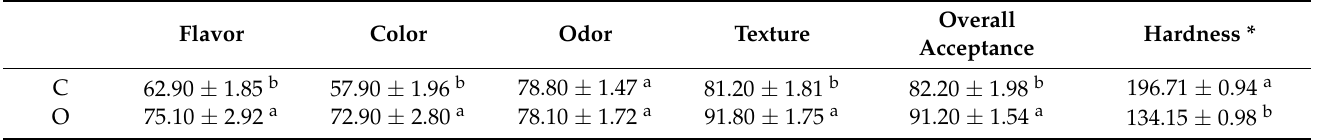
Table 9. Sensory evaluation and Hardness of control (C) and optimal (O)